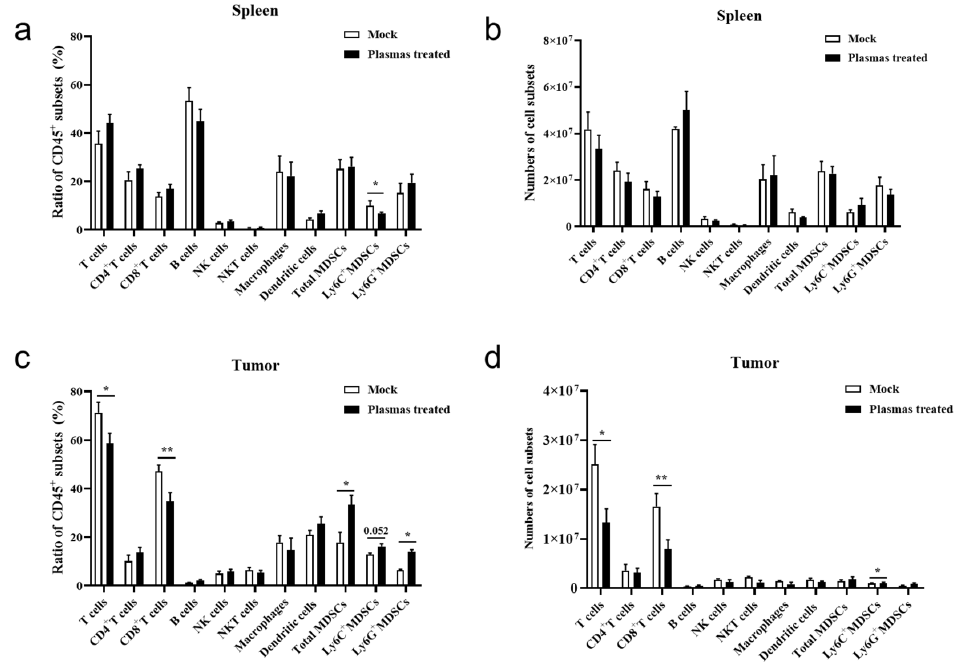
Figure 4. CAP treatment in vivo inhibits expansion of tumor-infiltrating CD8 + T cells. ( a , b ) Number and proportion of splenic immune cell subsets and ( c , d ) Tumor-infiltrating immune cell subsets in the mock and PT group mice determined by flow cytometry, n = 5. The data are from five biologically independent animals (means ± SD) and the statistical analysis is performed using two-sided unpaired t -tests (* p < 0.05, and ** p < 0.01).